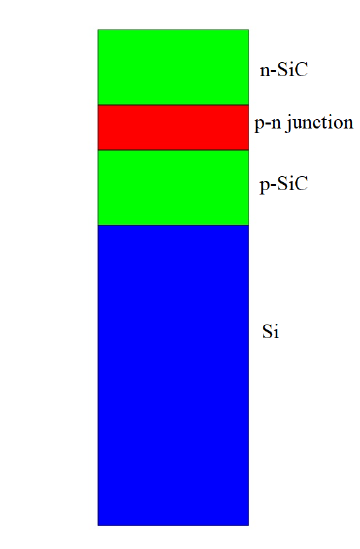
Figure 2. Model of beta-converter in GEANT4